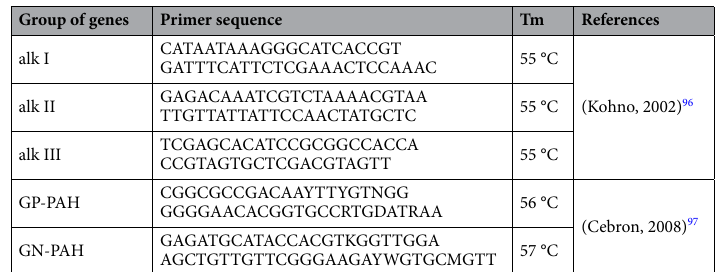
Table 3. Primers used in the